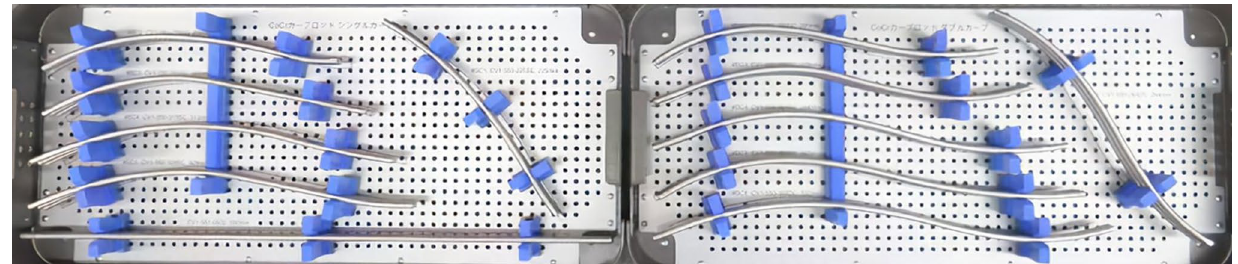
Figure 1. Anatomical notch-free, pre-bent rods for scoliosis surgery. Eleven types of rods can be utilized based on the length and curve types. The rod shapes were split up into two shapes: single curve and double curves. If the lowest instrumented vertebra (LIV) is L1 or above, two identical single-curve rods are used (left). If the LIV is L2 or L3, two identical double-curve rods are